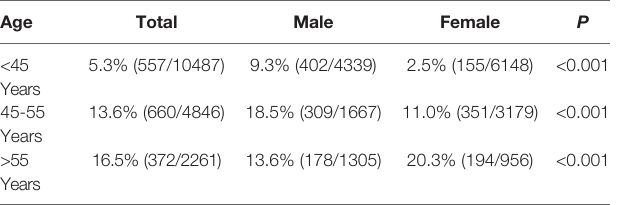
TABLE 4 | Prevalence of non-obese FLD among non-obese physical examinees of different age groups in 2016 [%(n+/n)].